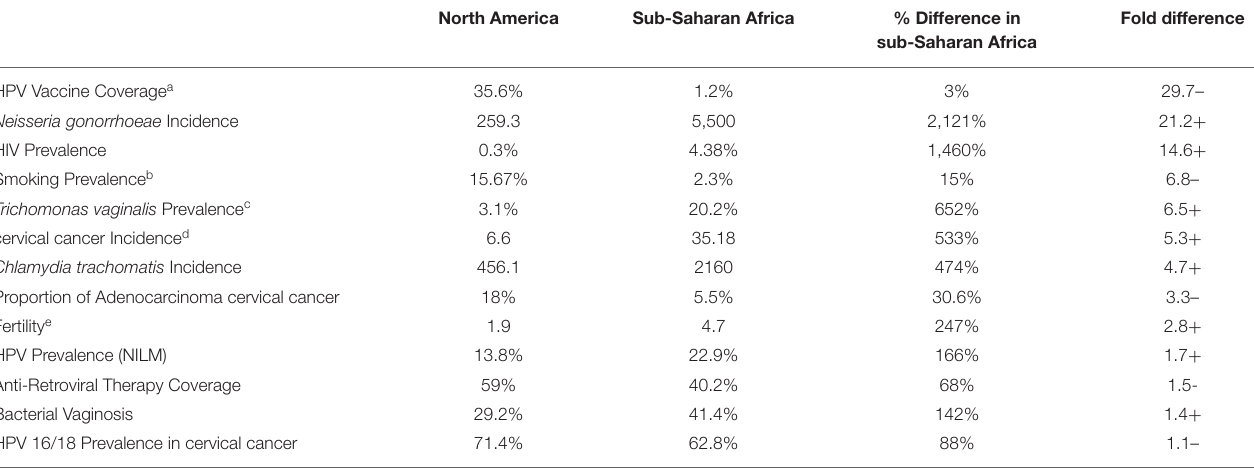
TABLE 1 | Comparison of factors which may influence cervical cancer in sub-Saharan Africa and North America (Koumans et al., 2007; WHO, 2012; Ferlay et al., 2013; CDC, 2014; CDC STD Surveillance, 2015; UN World Fertility Patterns, 2015; WHO Report on the Global Tobacco Epidemic, 2015; Bautista et al., 2016; UNAIDS Global AIDS Update, 2016; UNAIDS Database, 2017; Gonorrhea-CDC Fact Sheet,